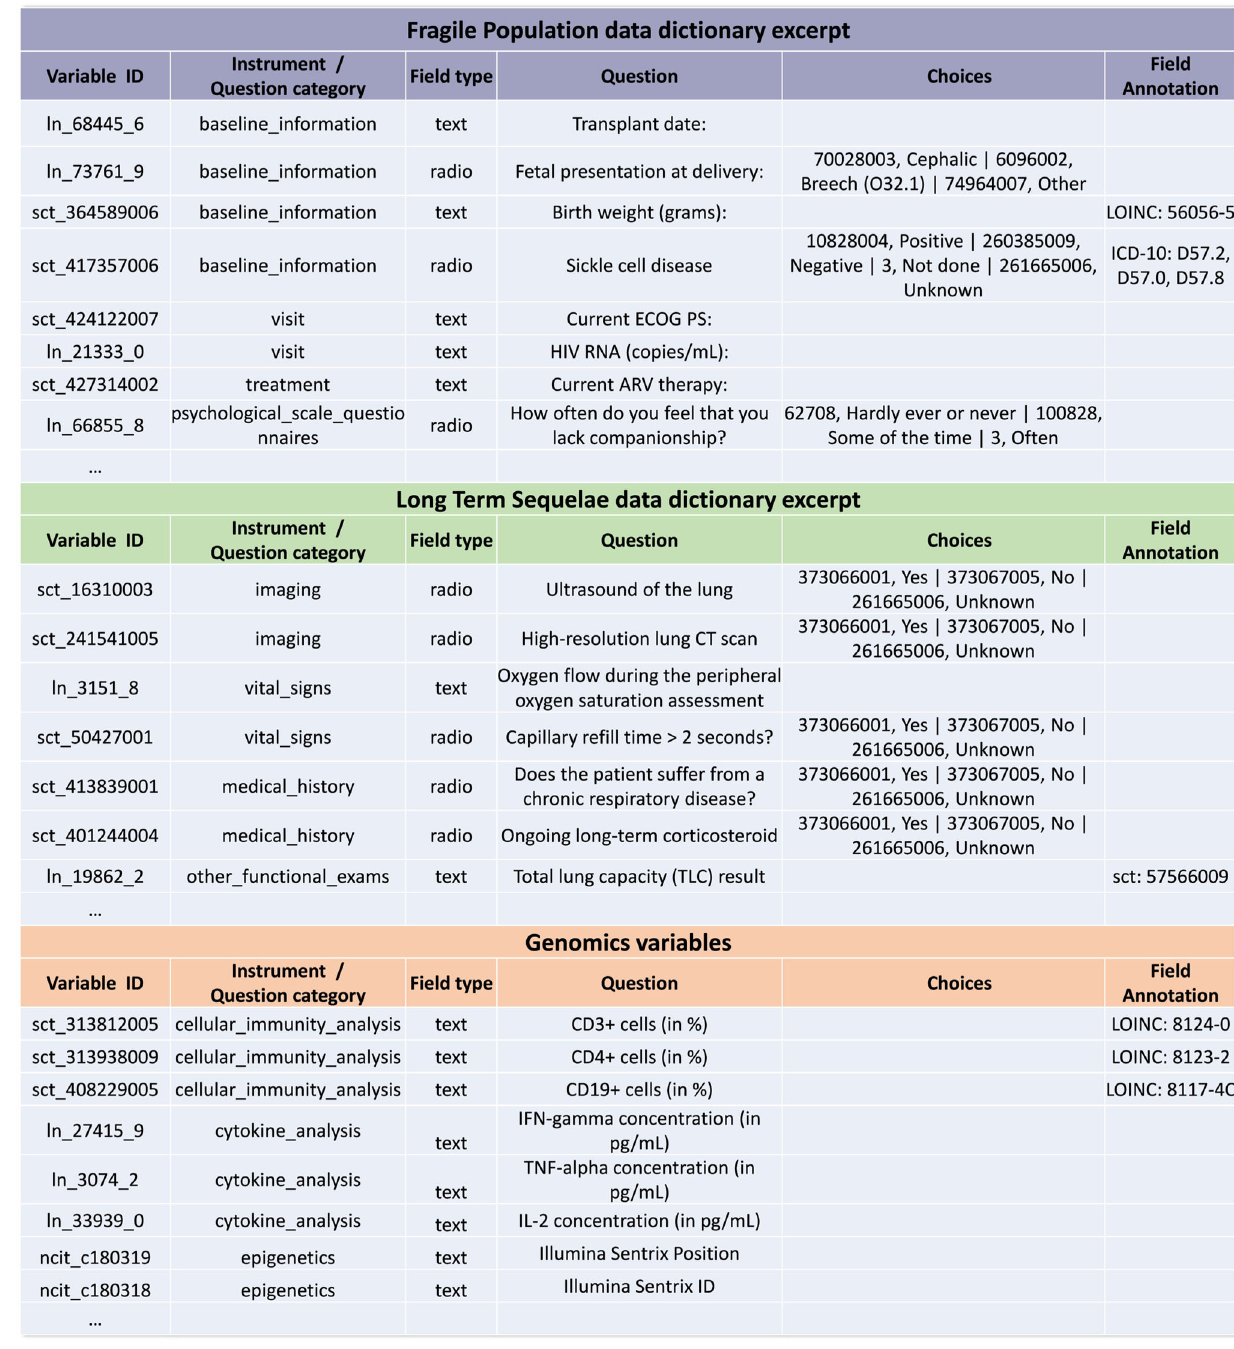
Fig. 1 Excerpts of both the Long-Term Sequelae and Fragile population data dictionaries and selected Genomics variables. Examples of data dictionary elements with standard terminology codes incorporated in the variable IDs and answer (choice) IDs are shown as well as additional semantic representations of a concept that were added in the Field Annotation column. ECOG PS Eastern Cooperative Oncology Group Performance Scale, HIV RNA Human immunode fi ciency virus ribonucleic acid, ARVAntiretroviral, CT Computer tomography, CD3 + cells Cluster of differentiation 3 positive T-cells, CD4 + cells Cluster of differentiation 4 positive T-cells, CD19 + cells Cluster of differentiation 19 positive B-lymphocytes, IFN-gamma Interferon gamma, TNF-alpha Tumor necrosis factor alpha, IL-2 Interleukin 2, pg/mL Pictograms per milliliter, ID Identi fi